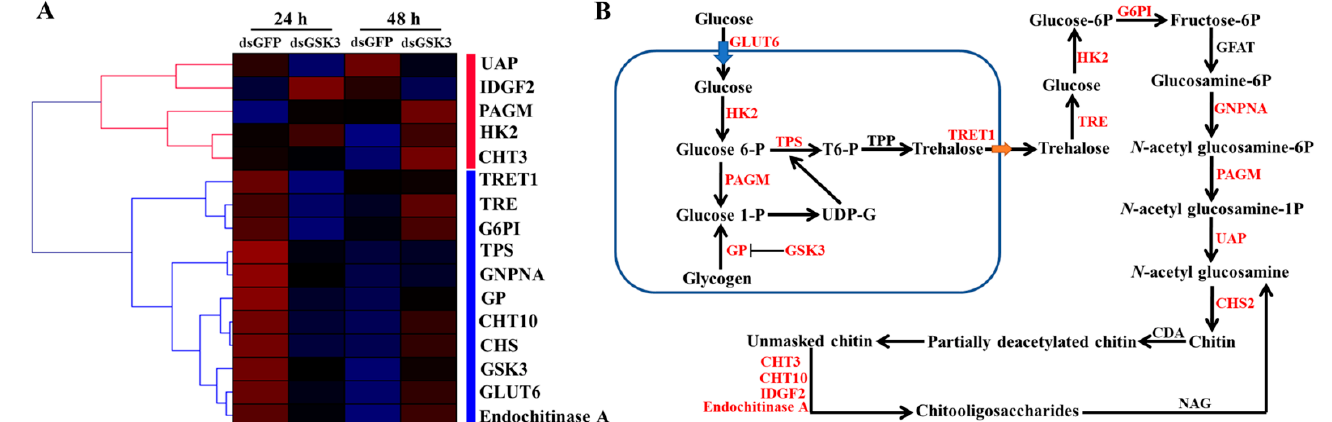
Figure 12. Hierarchical analysis for genes involved in chitin metabolism in different comparable groups. ( A ) Hierarchical analysis of genes related to chitin metabolism at 24 h and 48 h in ds DcGSK3 groups and ds GFP groups. DEG expression is shown with a pseudocolor scale (from − 3 to 3), with a red color indicating high expression levels and a bluish-violet color indicating low expression. ( B ) Analysis of chitin metabolism-related genes identified from D. citri transcriptome data. The red text indicates that these genes were identified from D. citri transcriptome data.